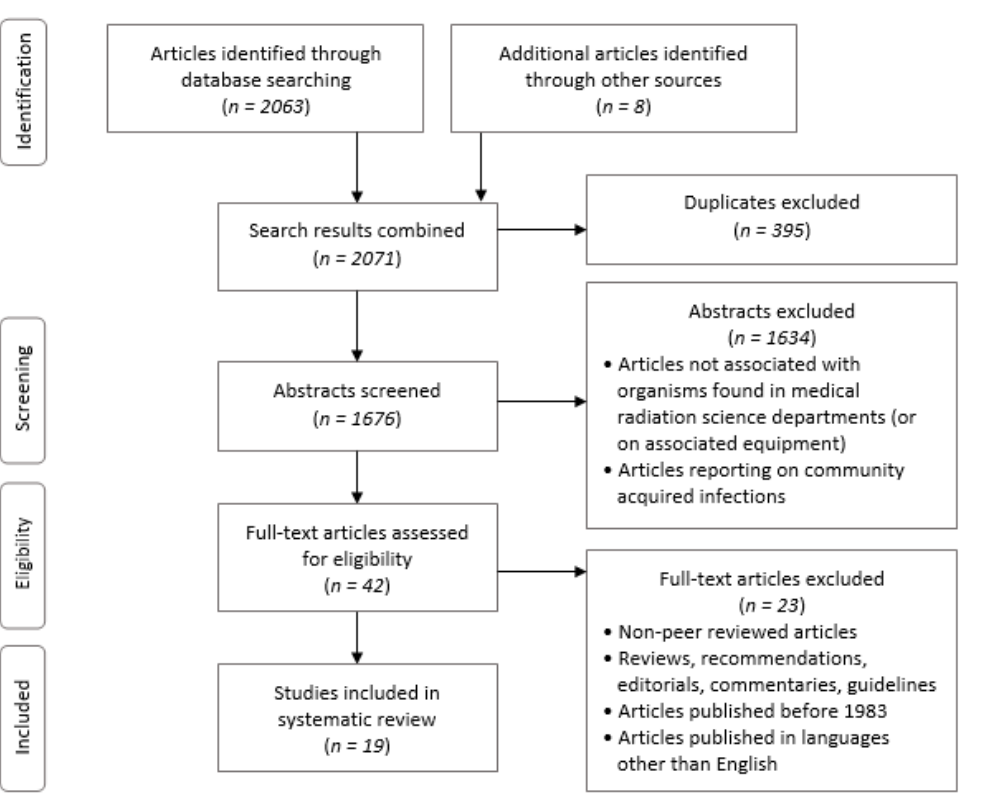
Figure 1. Preferred reporting items for systematic reviews and meta-analyses (PRISMA) flow